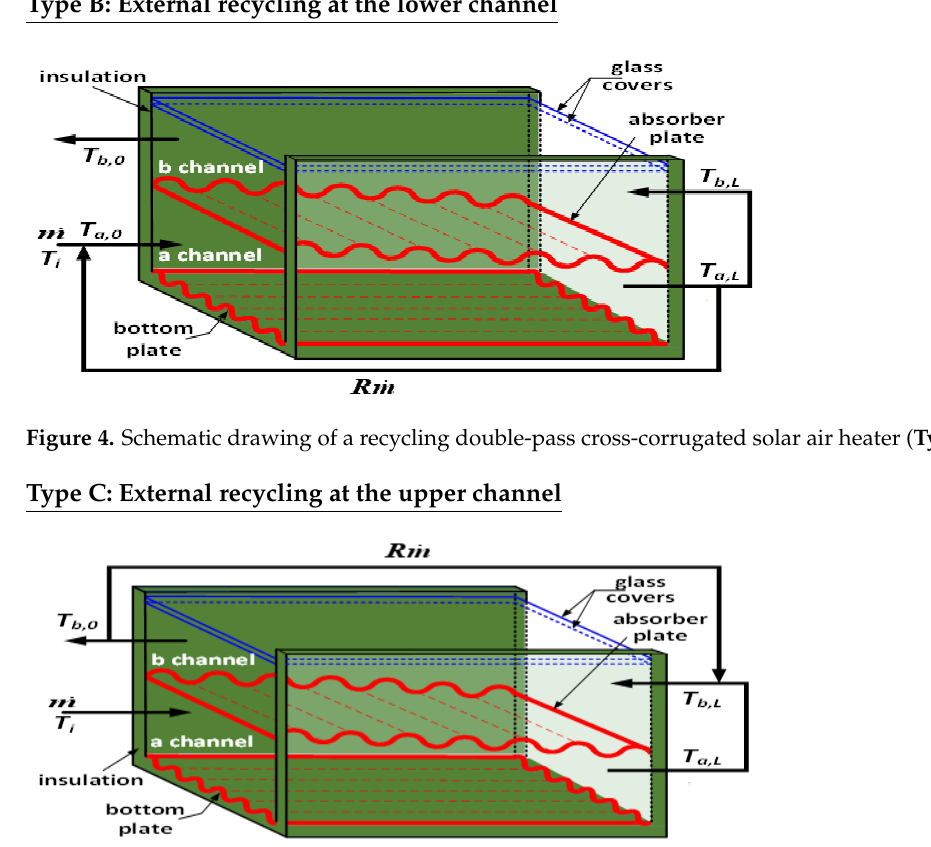
Figure 5. Schematic drawing of a recycling double-pass cross-corrugated solar air heater ( Type C ).